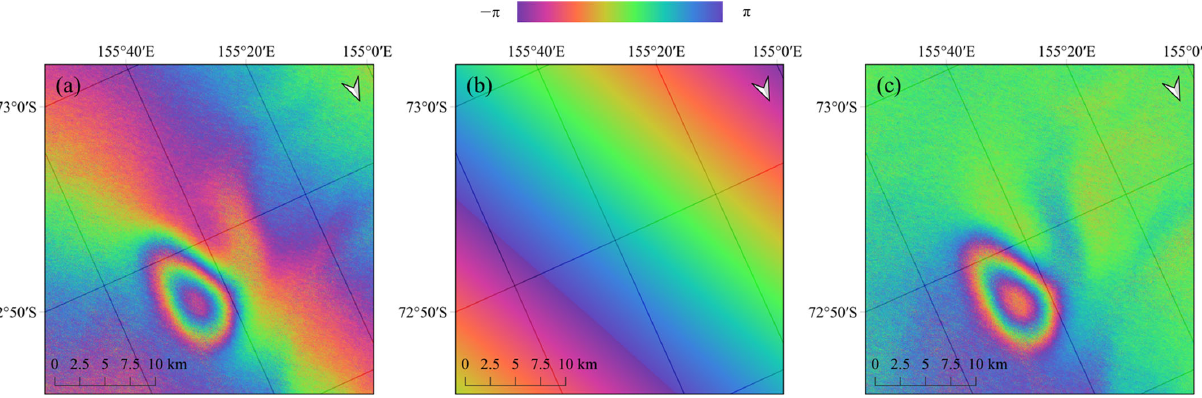
Figure 4. Example images of DInSAR reprocessing: ( a ) the image before linear phase elimination; ( b ) estimated linear phase; and ( c ) the image after linear phase elimination.